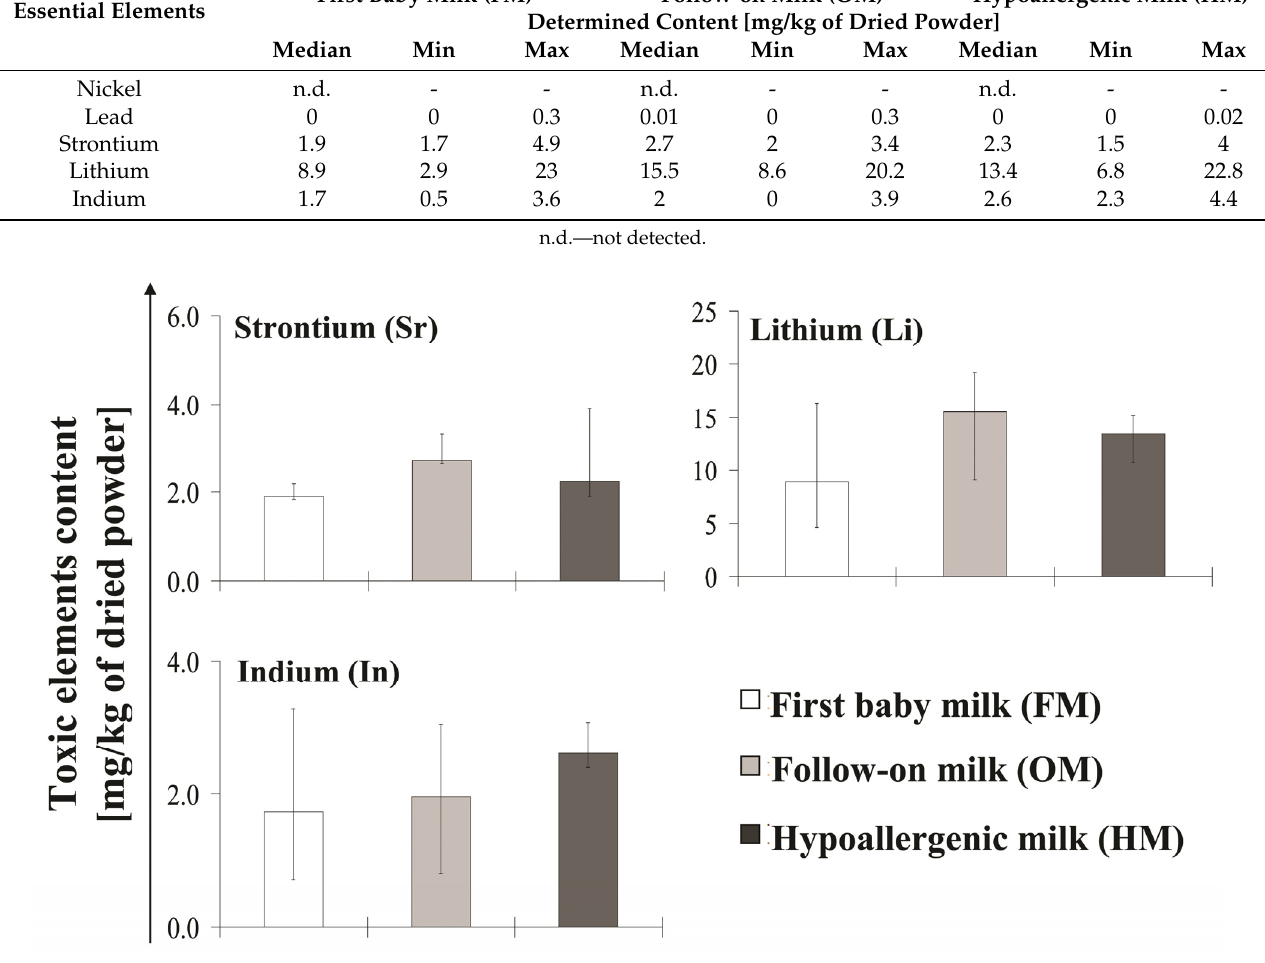
Figure 4. Concentration of the toxic elements contained in analyzed baby milk. The values of strontium (Sr), lithium (Li), and indium (In) content in analyzed first baby milk (FM), follow-on milk (OM), and hypoallergenic milk (HM). The data are presented as median (interquartile range) values of six determinations.